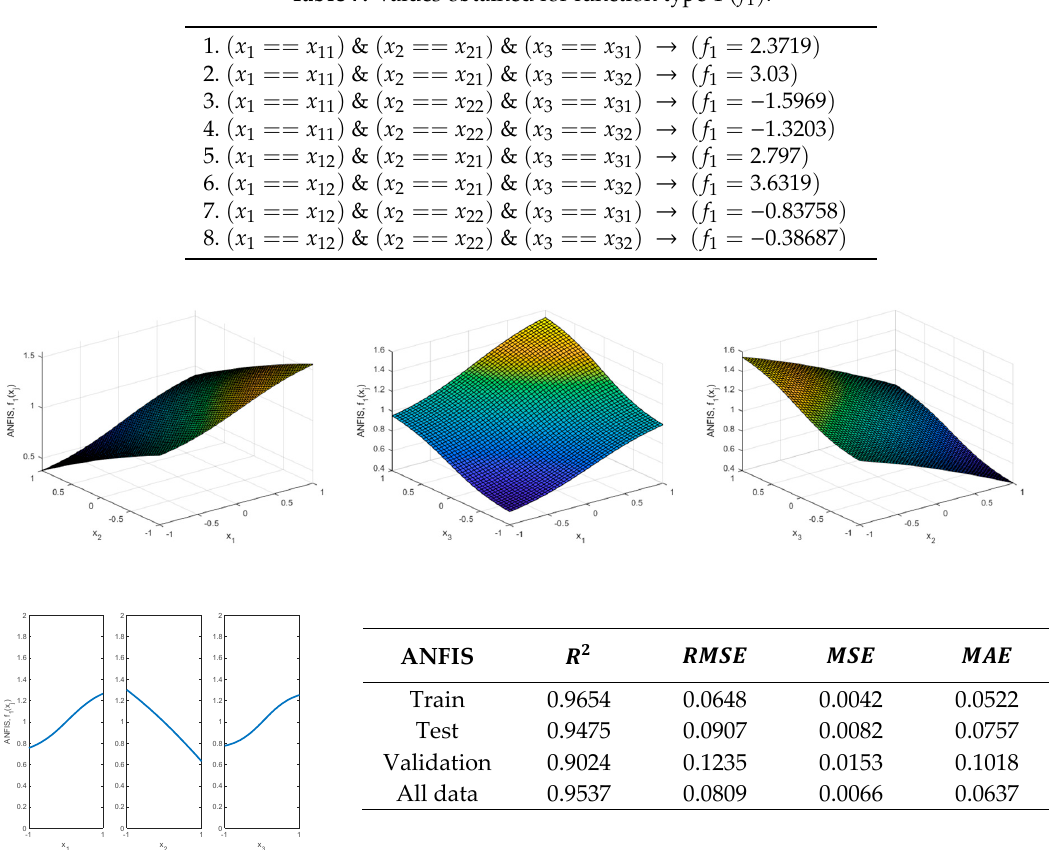
Figure 21. Response surface obtained with the zero-order Sugeno FIS employed for modeling f 1 using two Gaussian membership functions for the inputs along with an ANFIS (100 epochs, 8 fuzzy rules).